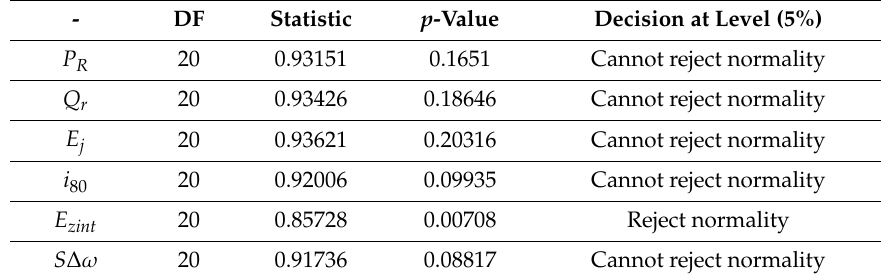
Table A1. Tests results of the normality of the Shapiro-Wilk distribution of variables for the process of rice